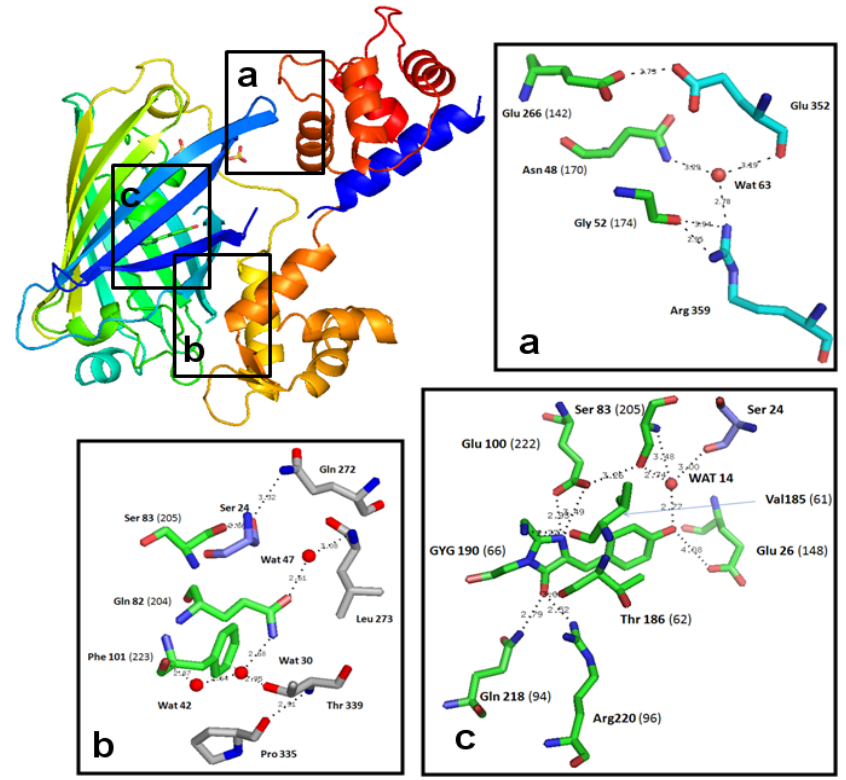
Figure 2. Ribbon diagram and key residues of the chromophore environment of Case16 structure A (colored in rainbow mode: N-terminus blue, C-terminus red). Insert “a” shows the loose contact of cpGFP with the C-terminal CaM lobe. Insert “b” shows the tight contact with the N-terminal lobe which is dominated by hydrophobic interactions. Insert “c” shows the local environment of cpGFP chromophore. Residue numbers indicated in brackets refer to wtGFP numbering. Residues with carbon atoms in green belong to cpGFP domain, residues with carbon atoms in cyan belong to CaM-domain and residues with carbon atoms in blue belong to